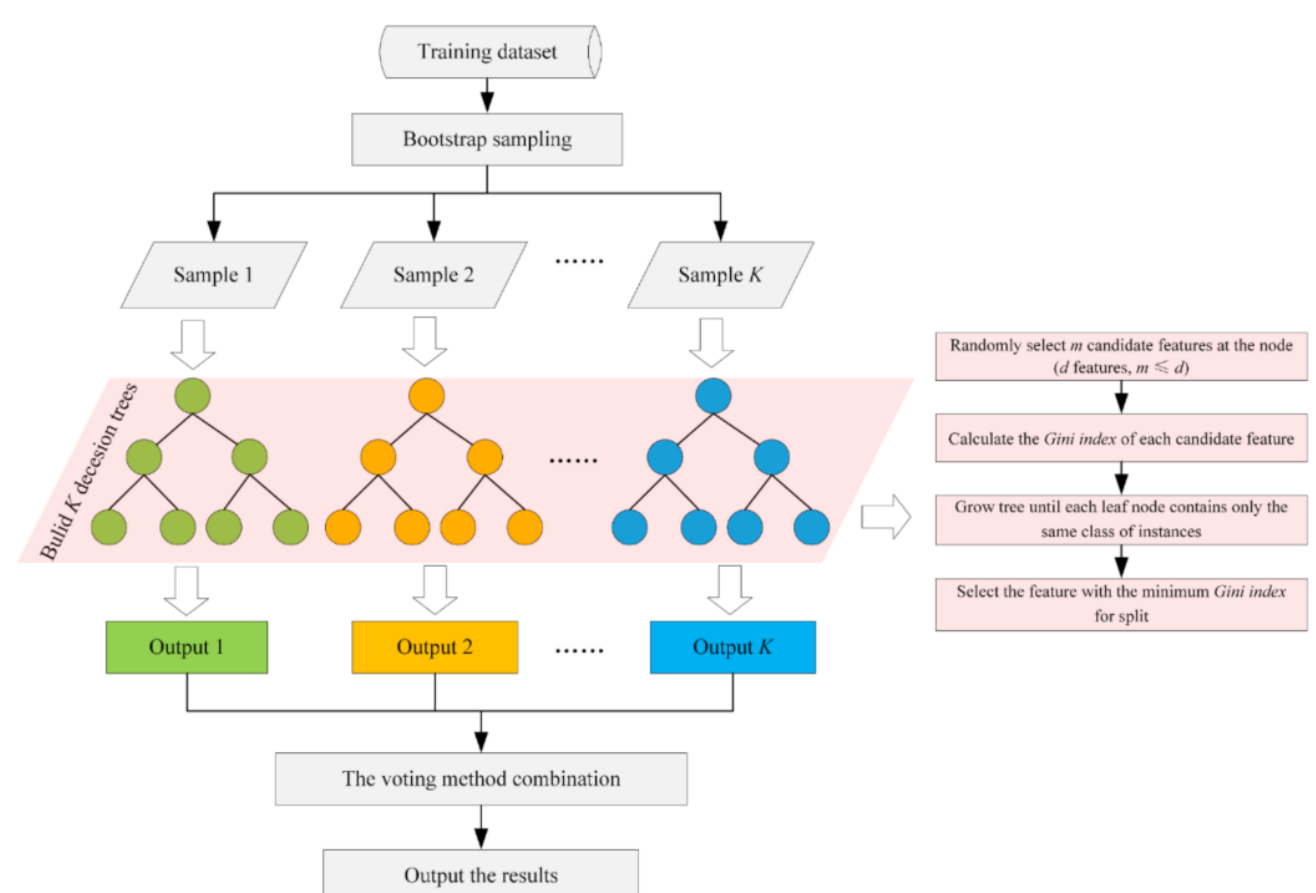
Figure 1. The flowchart to establish RF